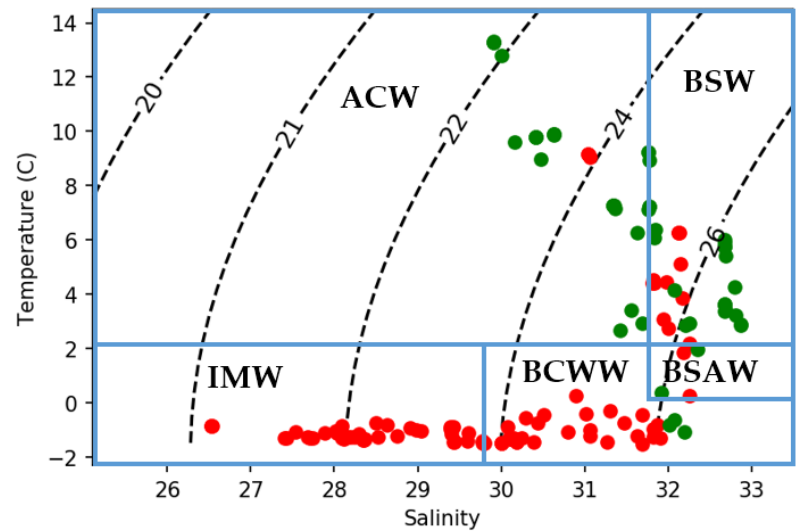
Figure 2. T–S diagram in the ARA07B (Red) and OS040 (Green). Alaskan coastal water (ACW), Ber- ing Shelf water (BSW), ice melt water (IMW), Bering–Chukchi winter water (BCWW), Bering Sea Anadyr water (BSAW).